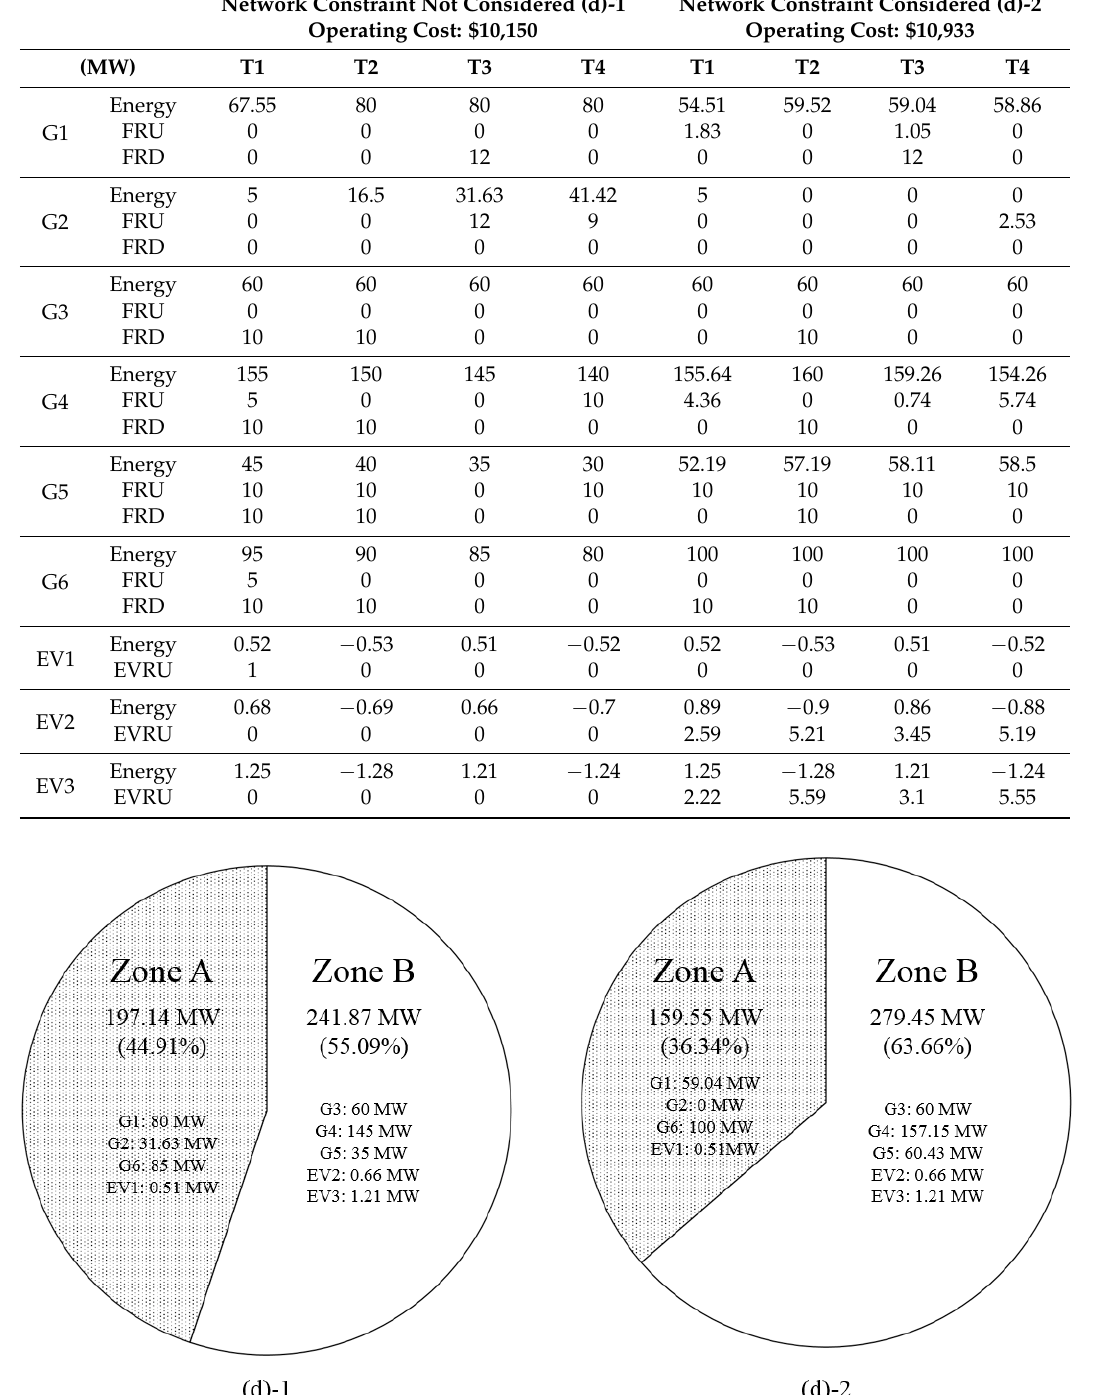
Figure 6. Comparison of power generation by zone at T3.